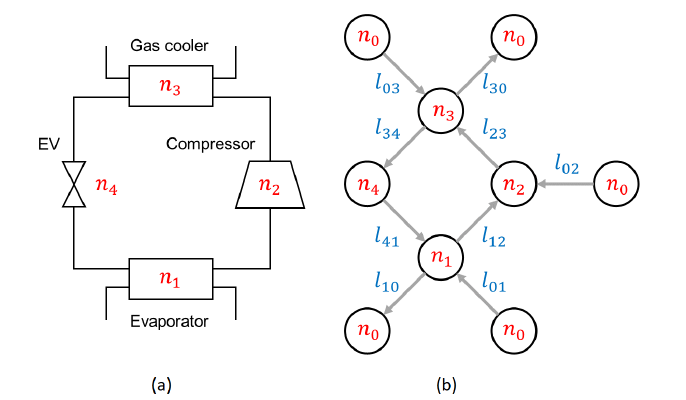
Figure 7. An attributed graph representation of the heat pump system: ( a ) schematic representation of the heat pump system, ( b ) graph